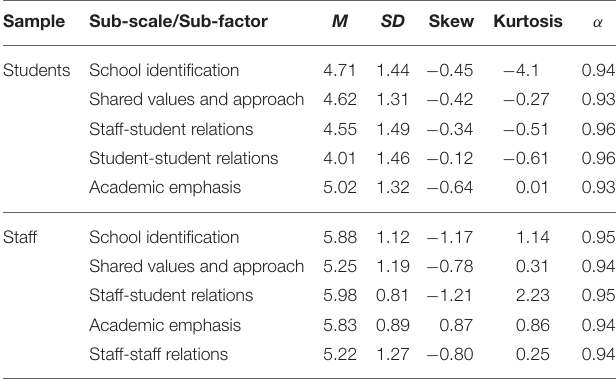
TABLE 1 | Means, standard deviations, skewness and kurtosis scores, and cronbach’s alpha for the scale scores in the student and staff samples. Sample Sub-scale/Sub-factor M SD Skew Kurtosis